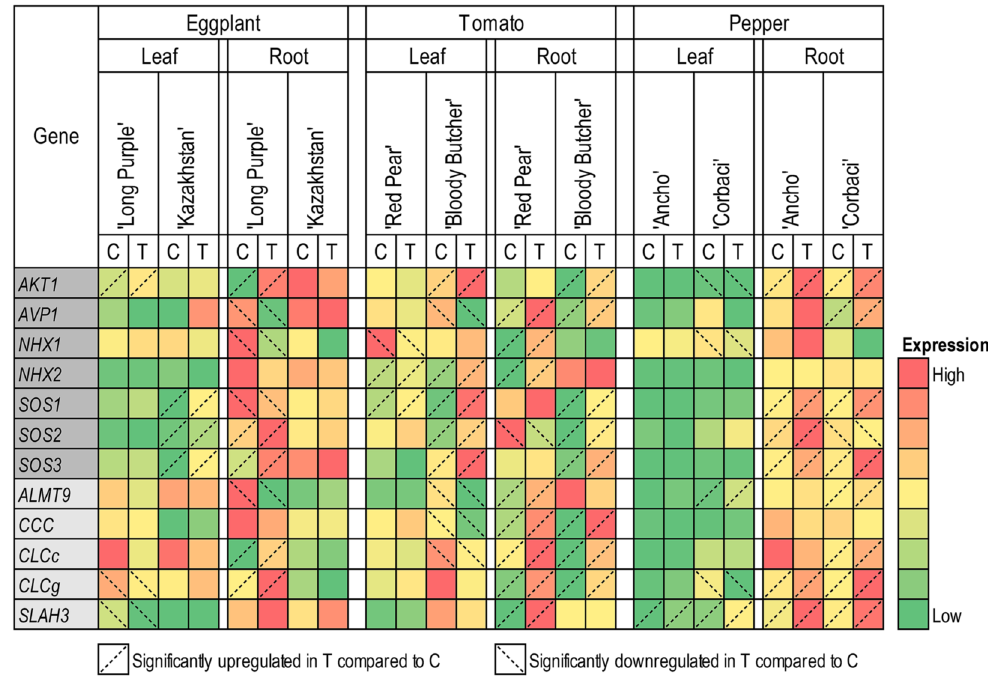
Figure 6. Heatmap representing the relative expression of salt stress-related genes in roots and leaves of a salt-tolerant and a salt-sensitive cultivar each of the three Solanaceae crops, eggplant, tomato, and pepper. Expression values for each gene are color-coded to depict the fold-change in different cultivars. The genes highlighted in dark gray represent genes involved in Na transport, and the genes highlighted in light green represent genes involved in Cl transport. C, control; T, salinity